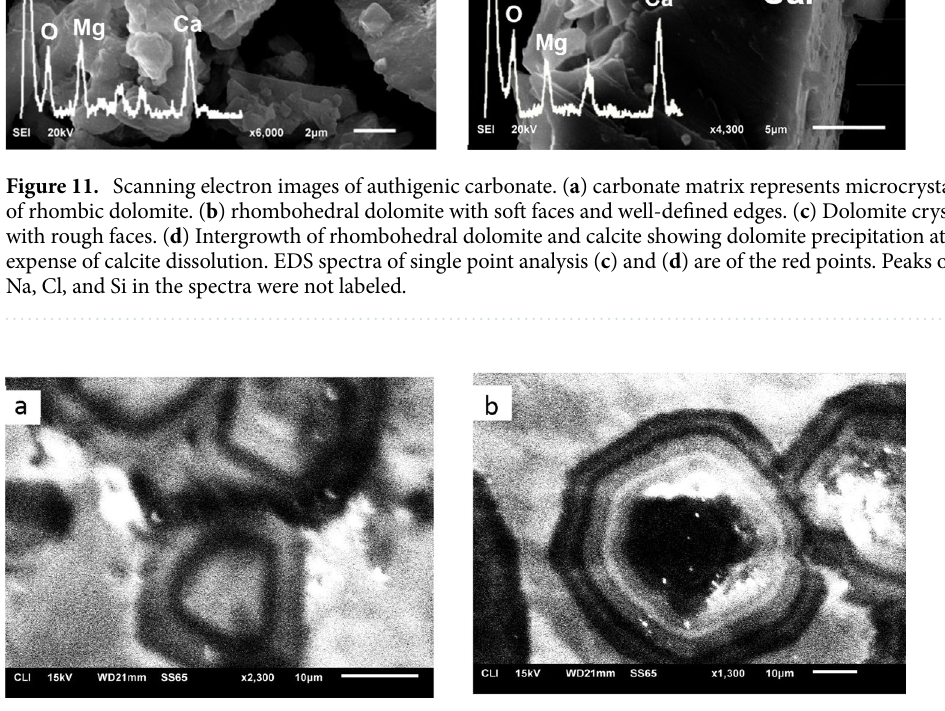
Figure 12. CL images ( a ) rounded spherulitic grains of dolomite. ( b ) zonation layers of dolomite with a hollow in the center of the grain. Dolomite zones show visible discontinuities where each zone is distinctive from the adjacent